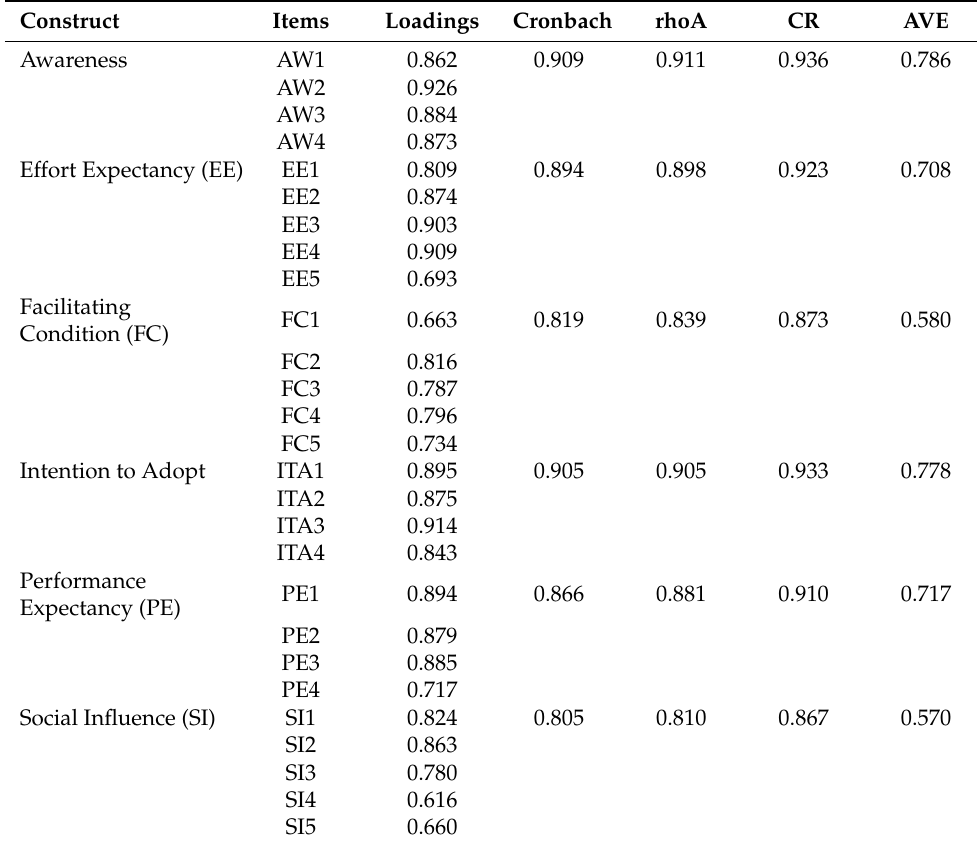
Table 2. Measurement Model: Convergent validity.